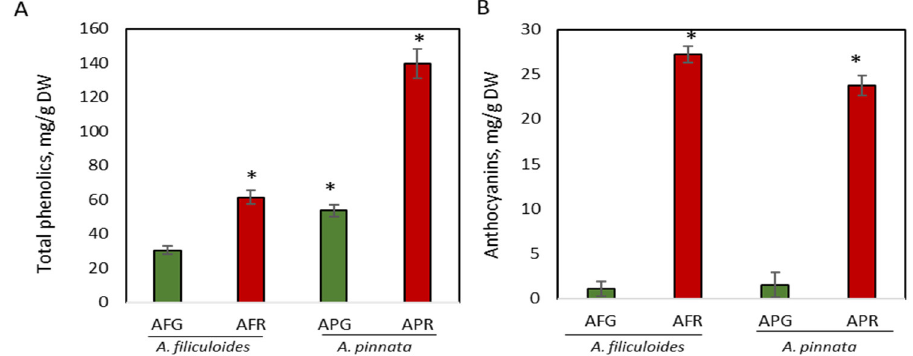
Figure 1. Accumulation of total phenolics ( A ) and anthocyanins ( B ) in green and red A. filiculoides and A. pinnata. AFG: A. filiculoides _Green; AFR: A. filiculoides _Red; APG: A. pinnata _Green; APR: A. pinnata _Red. (ANOVA; * p < 0.05 compared to AFG).